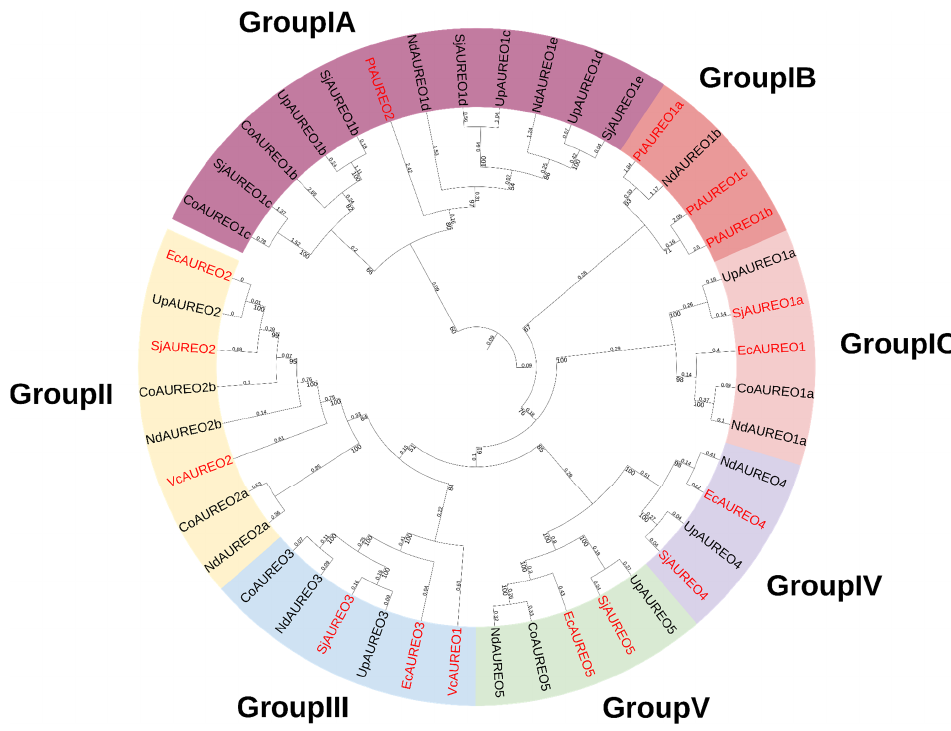
Figure 3. Phylogenetic relationship of AUREO proteins from Stramenopiles. The phylogenetic tree was constructed based on the sequence alignments of the AUREO proteins. The 44 AUREO proteins have been divided into seven groups, each filled with a different color, with the red marked genes representing the previously named AUREO.